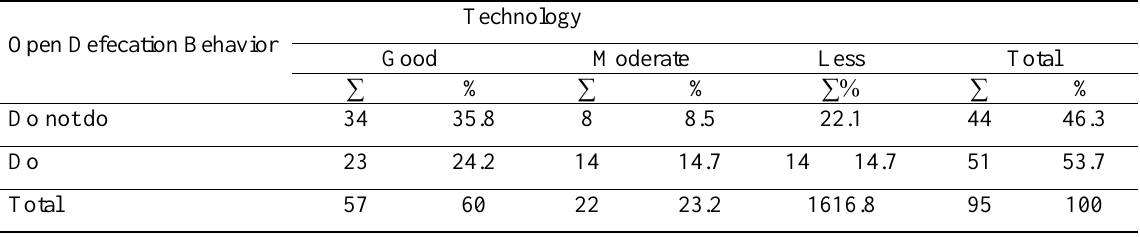
Table 6 The Relationship between Technological factors and Open Defecation Behavior of school age children Open Defecation